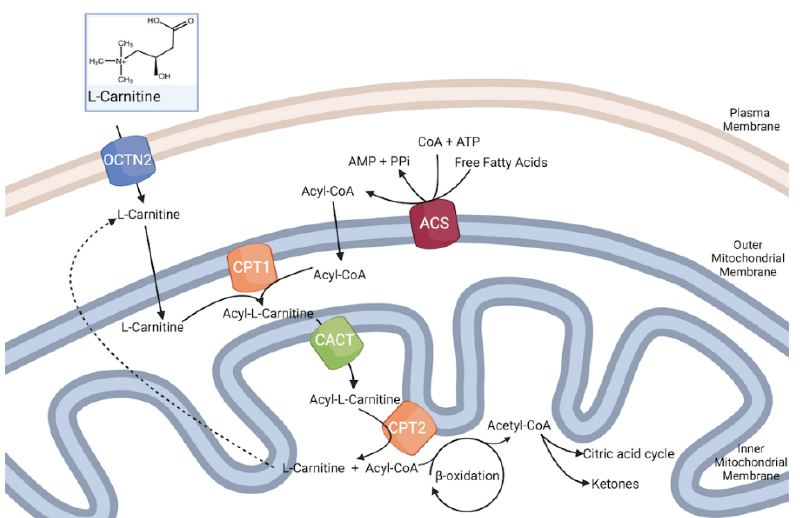
Figure 2. The carnitine shuttle. Long-chain fatty acids are converted to fatty acyl-CoAs by the enzyme acyl-CoA synthase (ACS), which is subsequently converted to fatty acylcarnitine by the enzyme carnitine palmitoyltransferase 1 (CPT 1), localized in the outer mitochondrial membrane. Fatty acylcarnitine is transported across the inner mitochondrial membrane via carnitine/acylcarnitine translocase (CACT) in exchange for L -carnitine. In the inner mitochondrial membrane, the enzyme carnitine palmitoyltransferase 2 (CPT 2) converts fatty acylcarnitine back to fatty acyl-CoAs and free L -carnitine, which exits the mitochondria and serves as the substrate for CPT 1 to form more acylcarnitine. These acetyl-CoA carbons then enter the citric acid cycle or are converted to ketones.